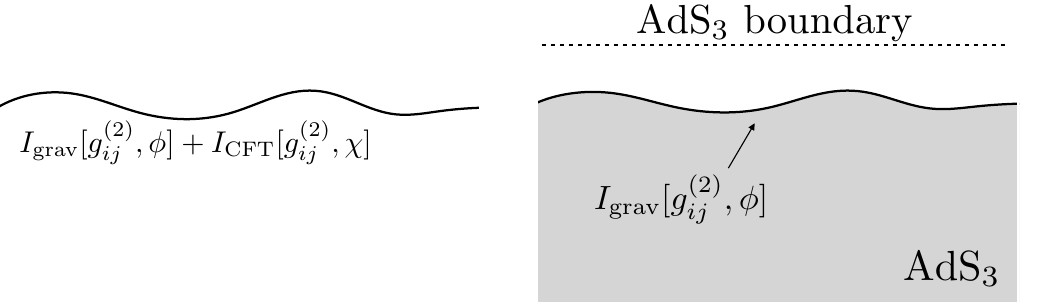
2 . The (cid:12)elds are also integrated over in the ij